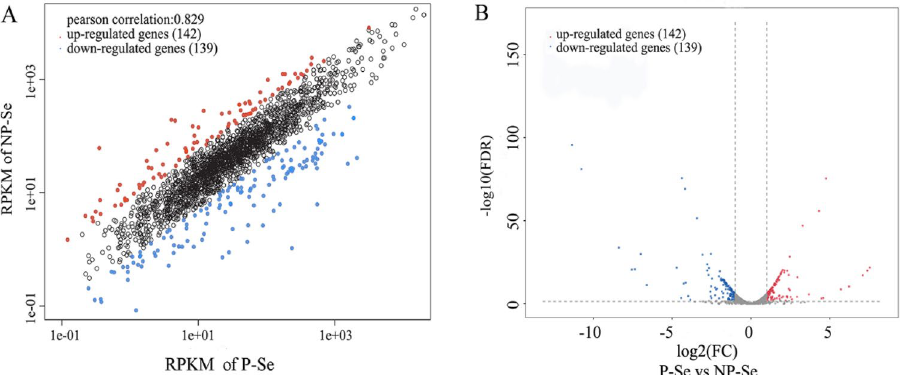
Figure 2. RNA-Seq analysis of differentially expressed genes (DEGs) of S. epidermidis isolates between postoperative endophthalmitis (P-Se) and the healthy conjunctiva (NP-Se). ( A ) A scatter plot demonstrating the expression variation of genes in two groups. The values of x- and y-axes represent the normalized signal values of the samples. ( B ) A volcano plot showing the DEGs in two groups with FDR ≤ 0.05 and |log2 FC|≥ 1 as the threshold. The red dots represent 142 significantly upregulated genes, and the blue dots represent 139 significantly downregulated genes in the group of P-Se compared with their expression levels in the group of NP-Se.